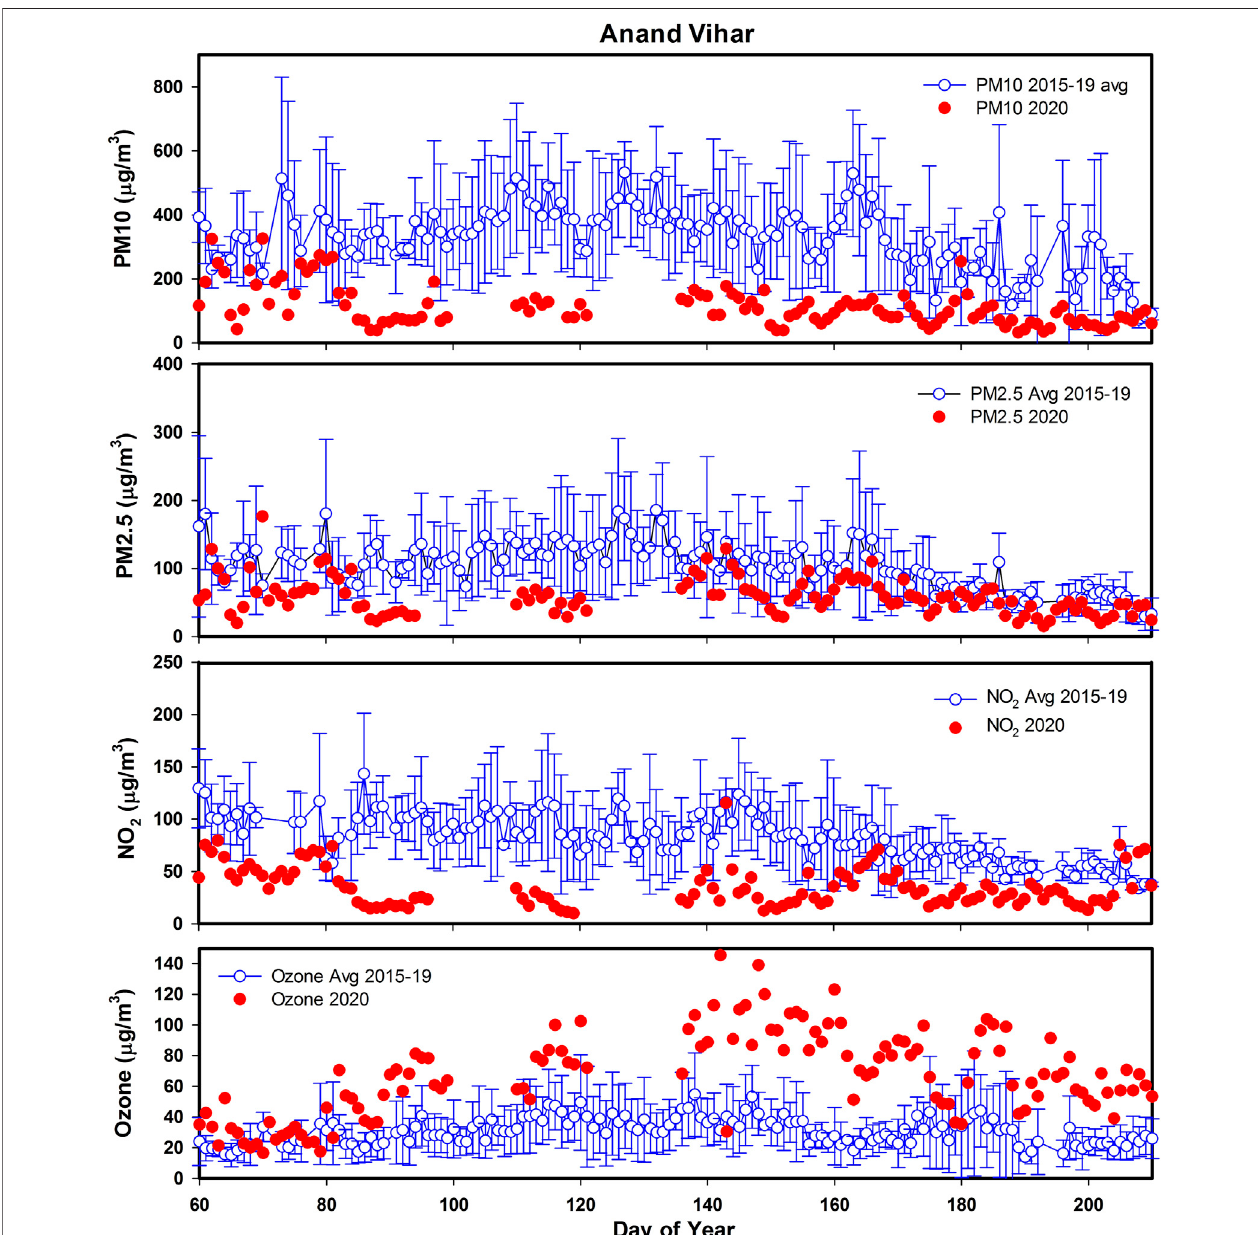
FIGURE 6 | Particulate matter and trace gases variations over a representative study location (Anand Vihar), Delhi during months corresponding to COVID-19 lockdown and unlock phases during 2020 and comparison with the average variation during 2015 – 2019.